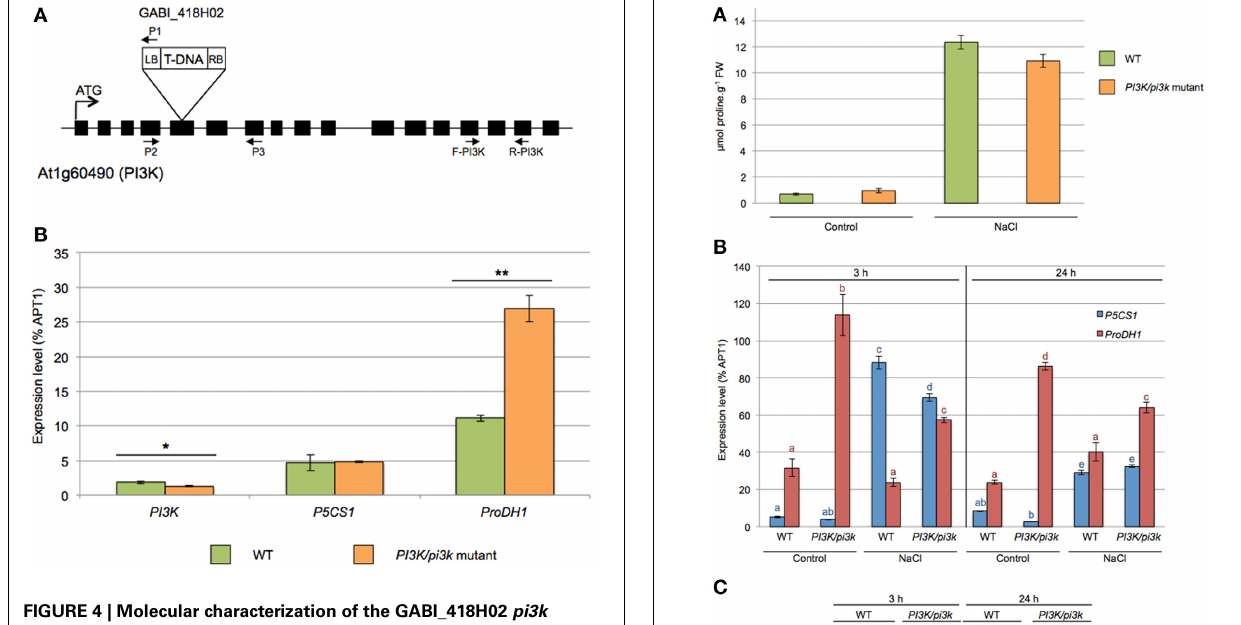
FIGURE 4 | Molecular characterization of the GABI_418H02 pi3k mutant. (A) Schematic representation of the T-DNA insertion in PI3K gene (At1g60490). Boxes indicate exons. In GABI_418H02 mutant, T-DNA insertion is located in the fifth exon of the PI3K gene. Primer 1 (P1) corresponds to LB08409 primer specific to left border of the T-DNA and primers 2 (P2) and 3 (P3) are gene-specific primers used for the genotyping. (B) Expression analysis by RT-qPCR of AtPI3K , AtP5CS1 and AtProDH1 in WT and PI3K/pi3k hemizygous mutant. cDNA were obtained from 12-days-old WT and PI3K/pi3k seedlings. Results expressed as percentage compared to APT1 as a reference gene are means ± SD ( n = 3). Significant differences of gene expression between WT and hemizygous seedlings are indicated by ∗ (Student’s T -Test, ∗ P < 0 . 05 and ∗∗ P < 0 . 01).